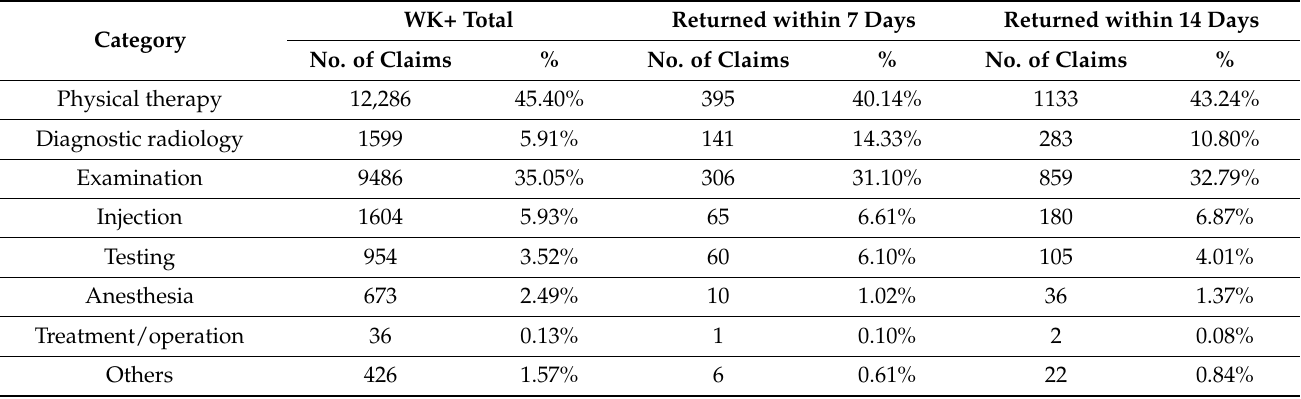
Table 5. WM interventions received among patients who alternated between KM and WM